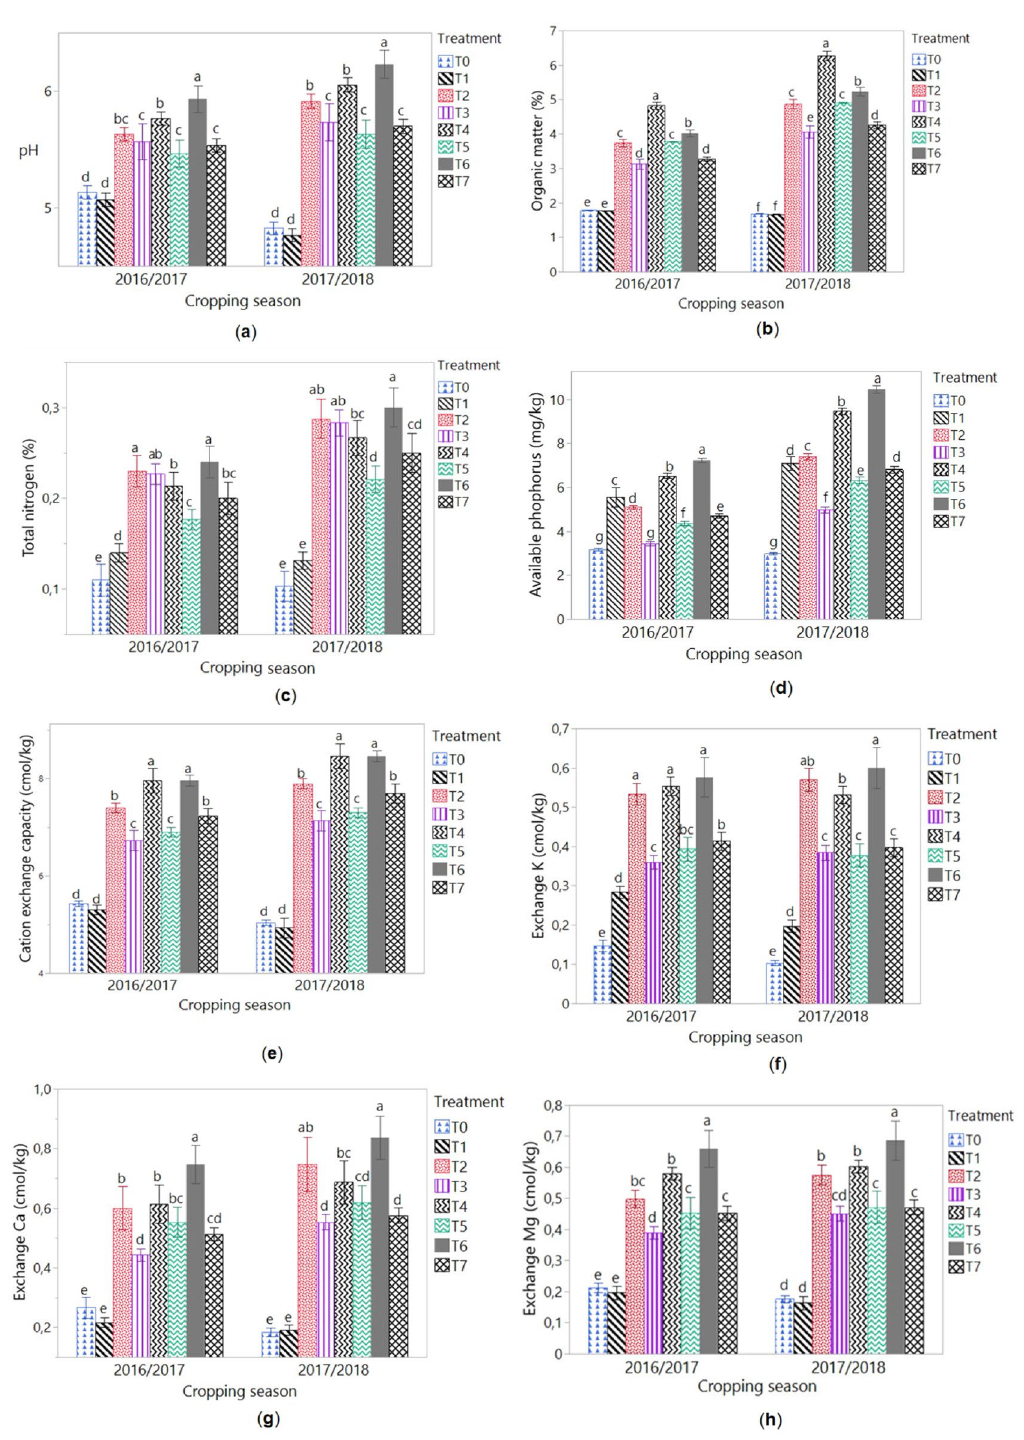
Figure 1. Means of soil chemical properties in 2016/2017 and 2017/2018 cropping seasons. T0 = control (no amendement), T1 = IF : 13-13-23 NPK at 450 t ha −1 + urea at 100 t ha −1 , T2 = TB at 20 t ha −1 , T3 = TB at 10 t ha −1 , T4 = PM at 20 t ha −1 , T5 = PM at 10 t ha −1 , T6 = TB at 10 t ha −1 + PM at 10 t ha −1 , T7 = TB at 5 t ha −1 + PM at 5 t ha −1 . TM Tithonia diversifolia fresh biomass, PM poultry manure, IF inorganic fertilizer. Values followed